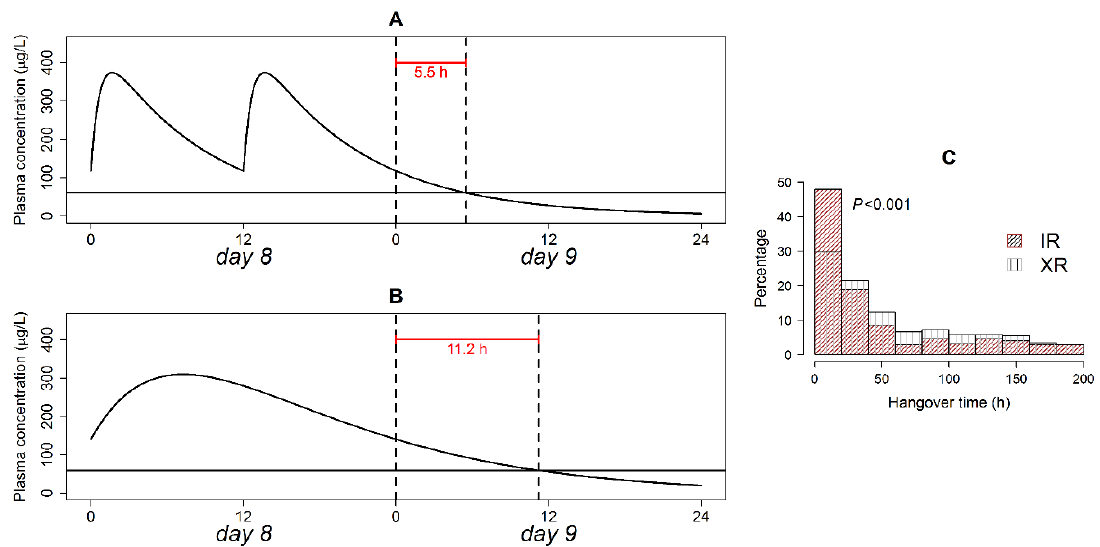
Figure 4. Quetiapine hangover time in a typical patient following the discontinuation of the IR ( A ) and XR ( B ) formulation administration; and relative frequency of hangover times in patients on both formulations ( C ). The solid horizontal line in panels A and B is the plasma concentration associated with a 14% reduction in BPRS score from baseline. p -value of the Kolmogorov–Smirnov test is shown in panel ( C ).